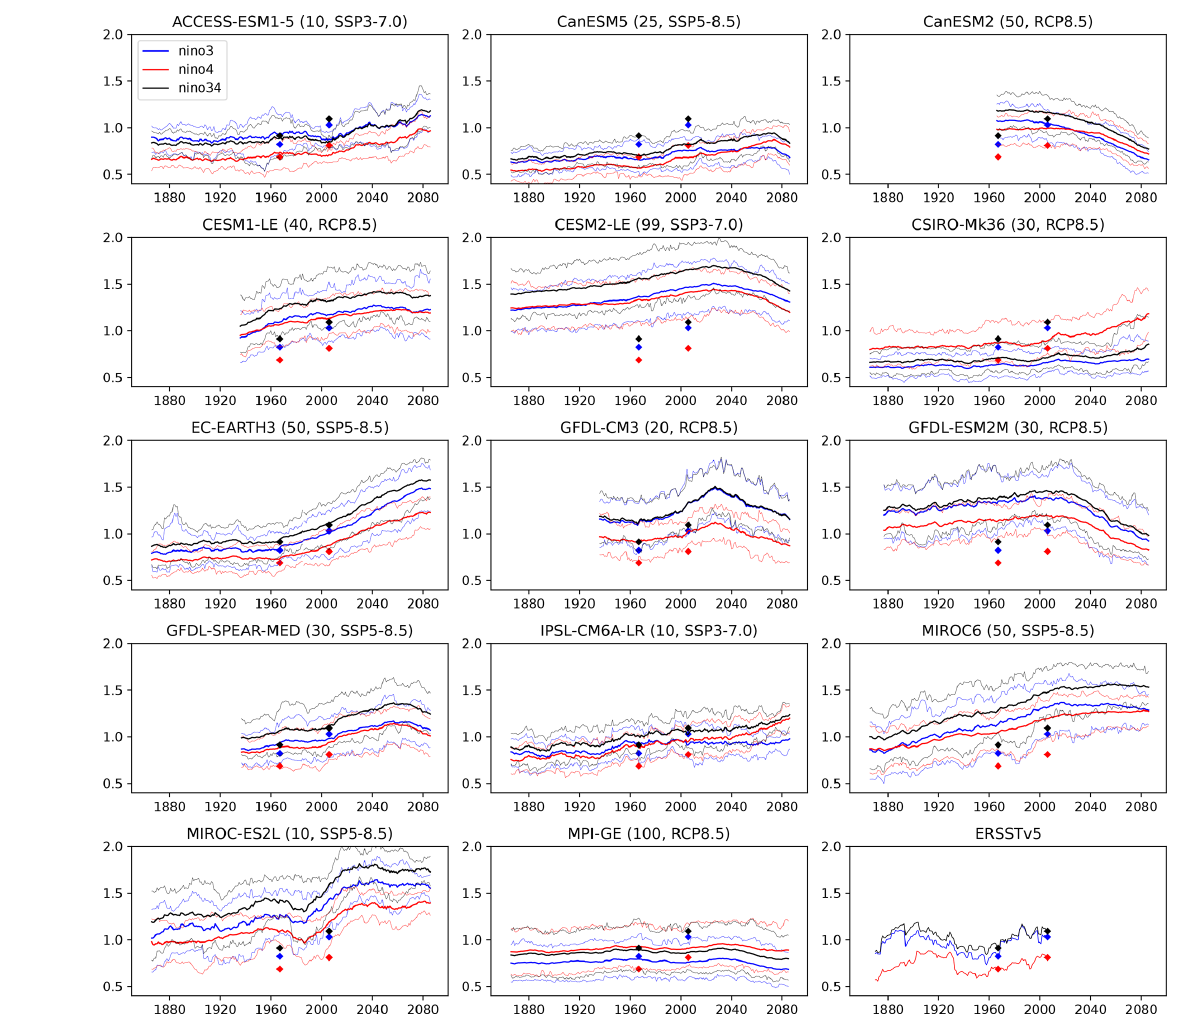
Figure 1. Time series of Niño3 (blue), Niño3.4 (black), and Niño4 (red) variability for the December, January, and February average (DJF) in each model. Variability is computed as the running 30-year standard deviation for each ensemble member after detrending each member by removing the ensemble mean. The DJF mean is taken prior to computing the variability for this and all subsequent figures. The thick line shows the ensemble mean of the running standard deviation, and the thin lines show the 5%–95% range across the ensemble. The bottom right panel shows the running standard deviation for ERSSTv5 observations (linearly detrended). The diamond symbols in each panel show the observed variability for the periods 1951–1980 and 1990–2019. Model name, ensemble size, and scenario used are shown in the title of each panel for all